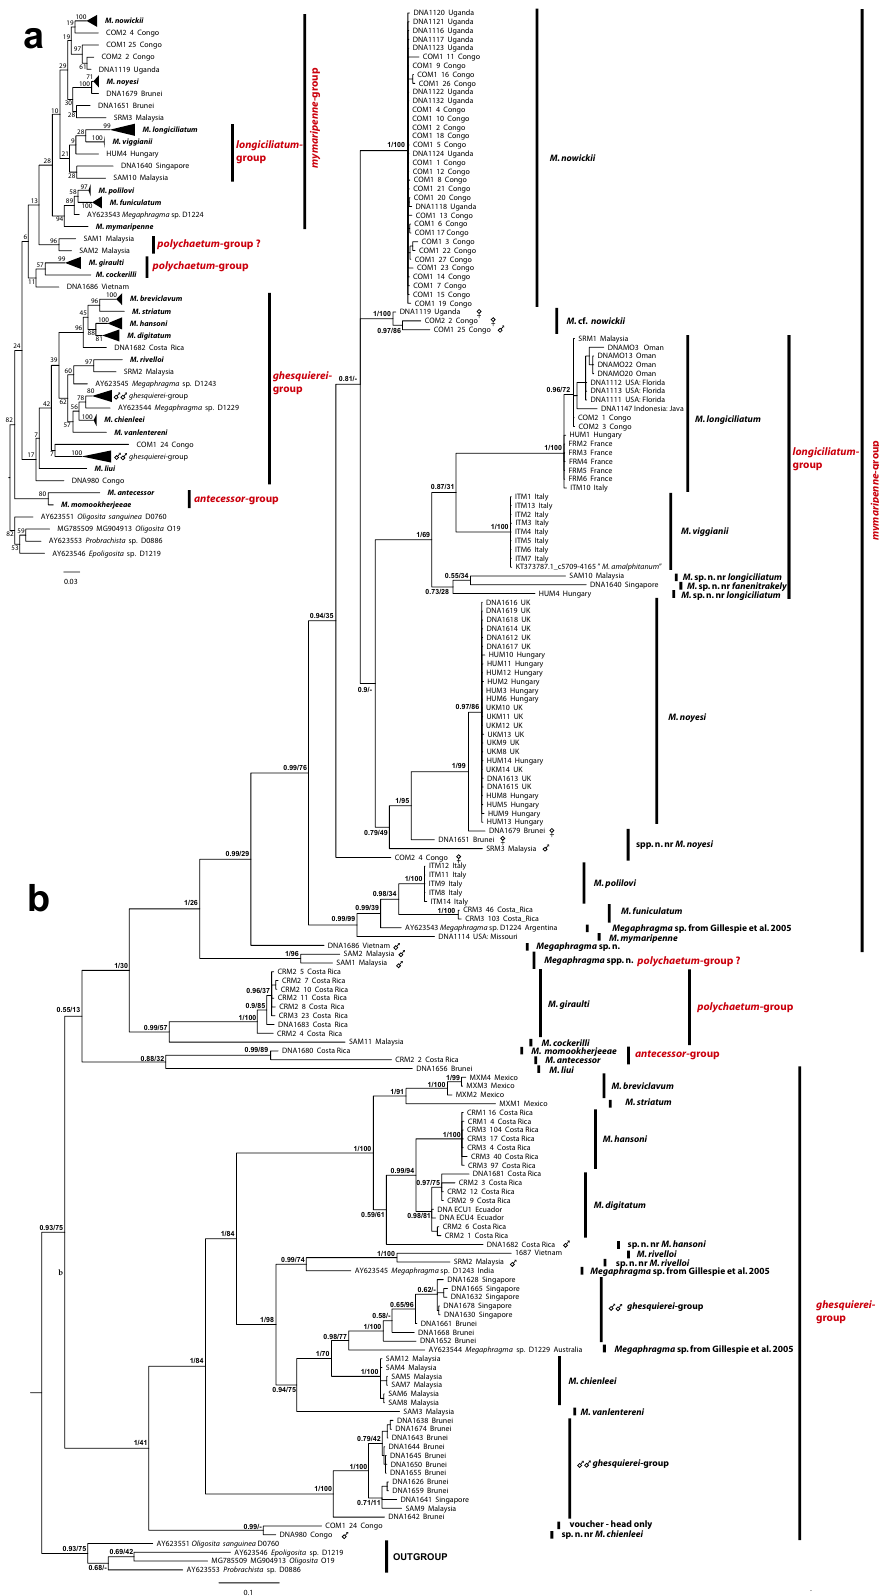
Figure 2. Combined CO1 and 28S sequences analysis of 174 Megaphragma specimens (170 from this study, 4 from GenBank) with species delineated and species-groups indicated: ( a ) unpartitioned ML analysis (bootstrap values indicated at nodes); ( b ) partitioned BI analysis (both posterior probabilities and bootstrap values indicated at